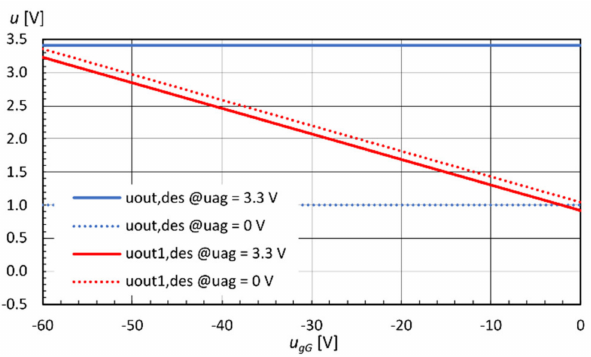
Figure 12. OP amp output u out vs. u gG for the measurement of u ag and designated reference